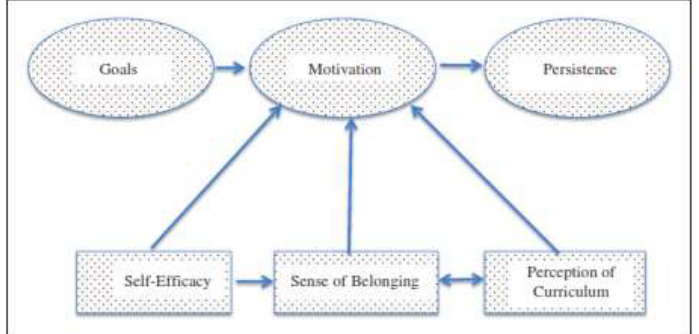
Illustration of Tinto’s Model of Student Persistence and